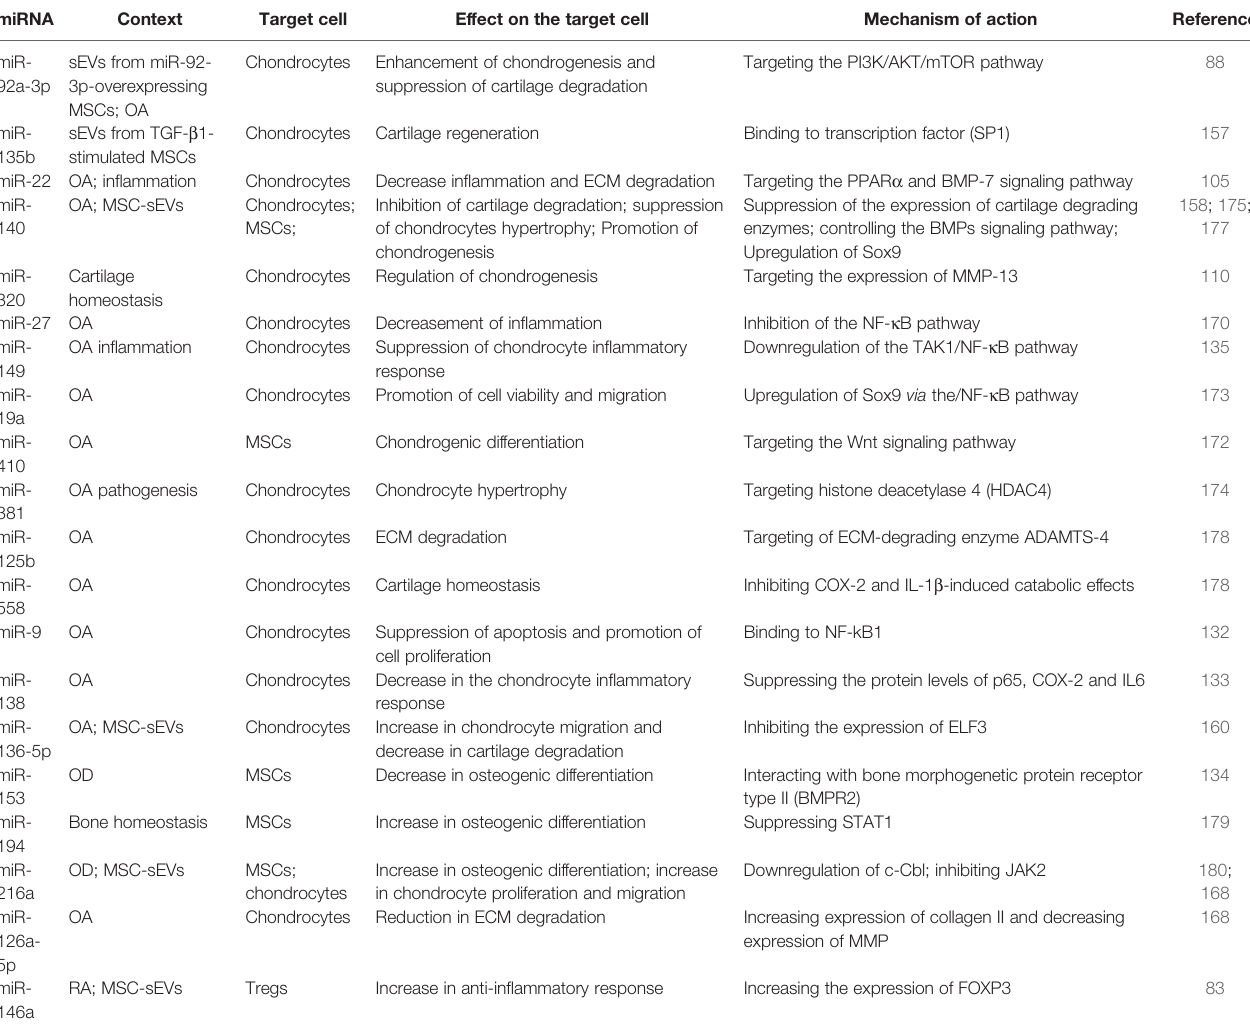
TABLE 1 | Summary of the literature reporting the role of miRNAs in OD.